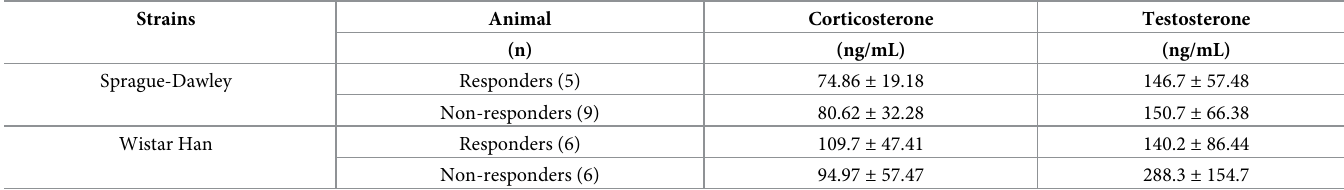
Table 4. Corticosterone and testosterone concentration comparison between 22-kHz responders and non-responders.